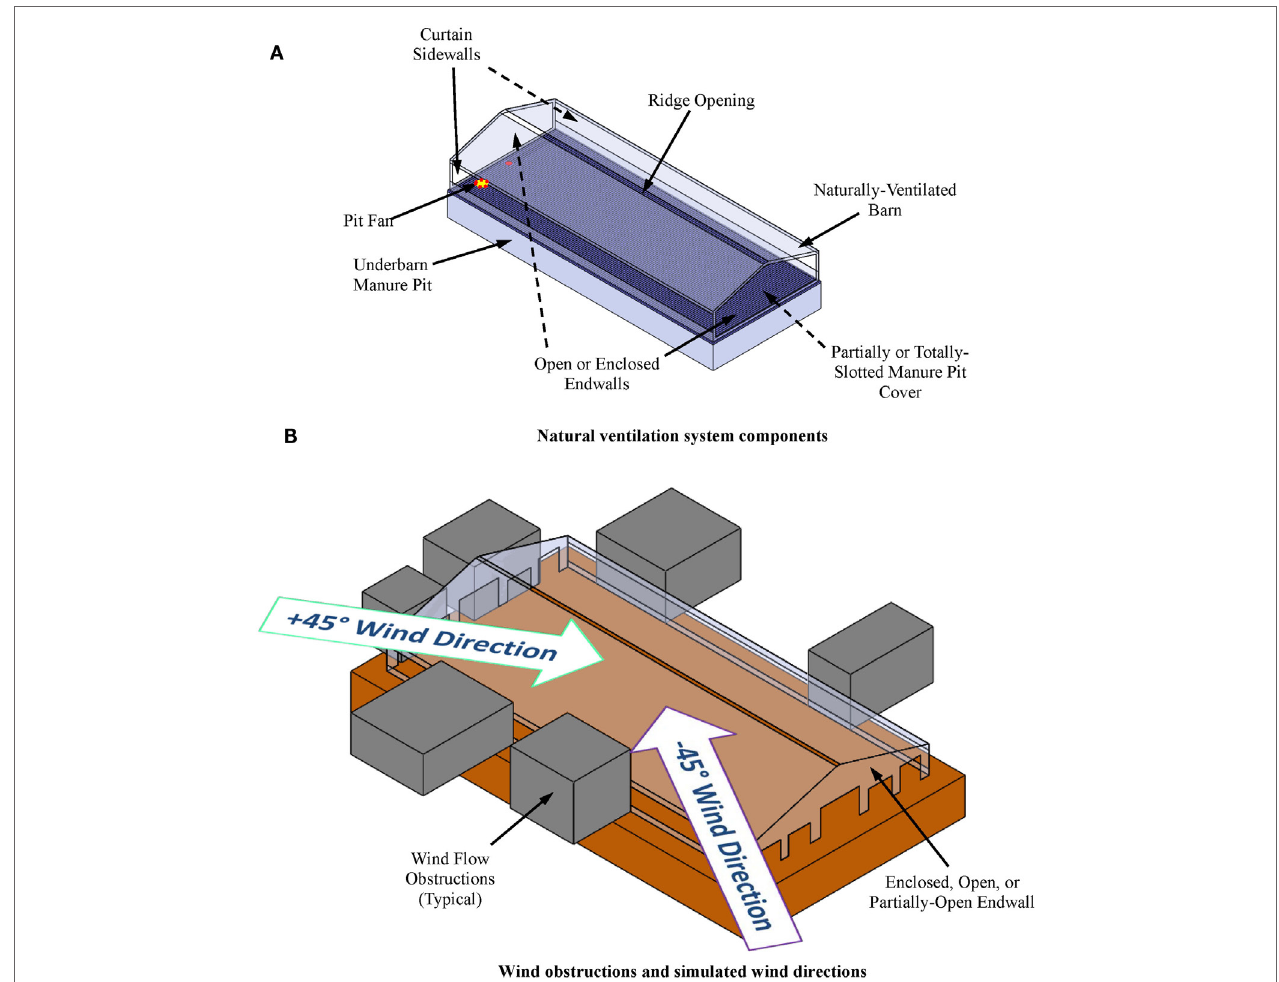
FIgURe 4 | Definition sketches for naturally ventilated barn above slotted-covered manure pit . (A) Natural ventilation system components and (B) wind obstructions and wind directions simulated by online design